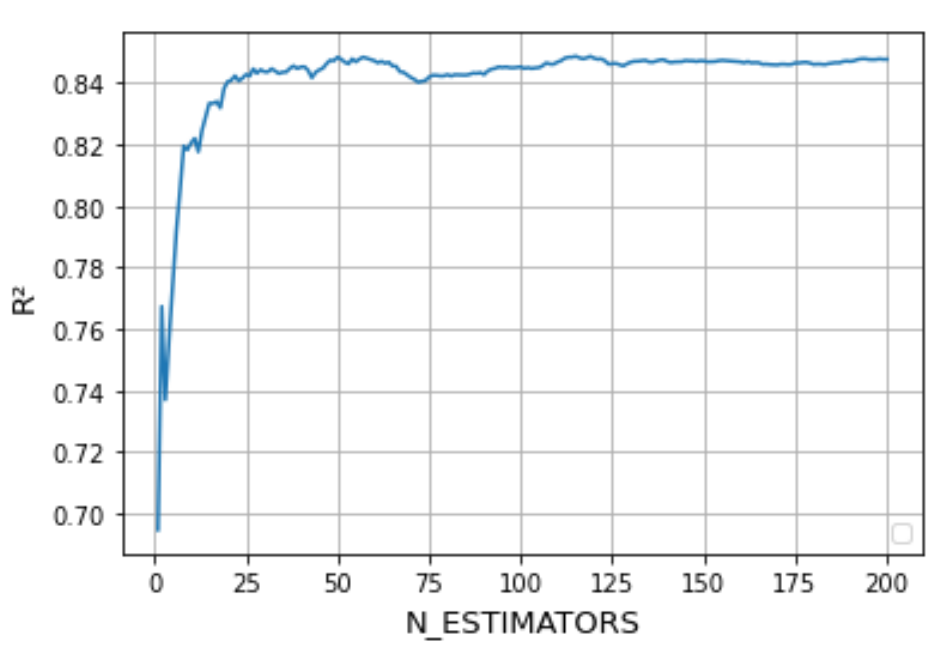
Figure 7. Parametric learning curve of random forest.